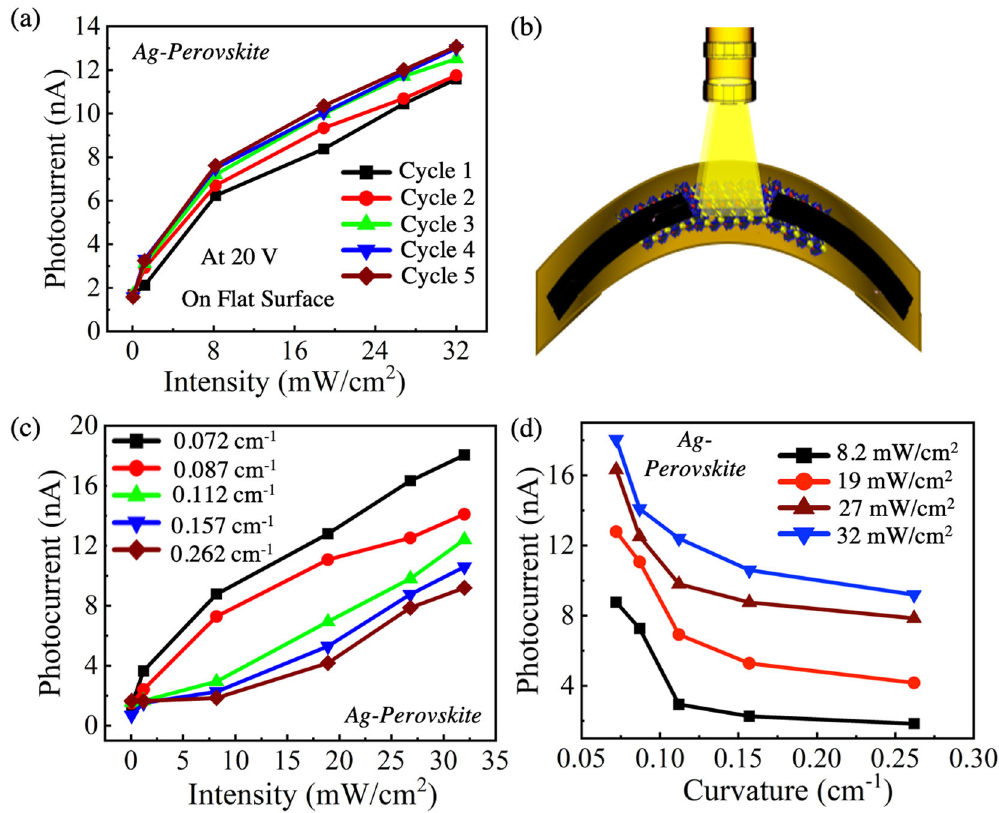
Fig. 6 Strain dependency. a Five repetitive cycles of the I p versus F , when the Ag-perovskite PD was on a fl at surface. The I p did not change signi fi cantly for all the fi ve cycles tested over the entire range of F tested, which con fi rms the reproducibility of our inkjet-printed PD devices. b Schematic diagram of the strained Ag-perovskite PDs, while under illumination which was inkjet printed on the fl exible PI substrate. c The change in I p as a function of F for various strain/curvature levels: ~0.072, 0.087, 0.112, 0.157, and 0.262 cm − 1 . d The dependency of I p as a function of curvature for various F , where the I p decreased as the curvature